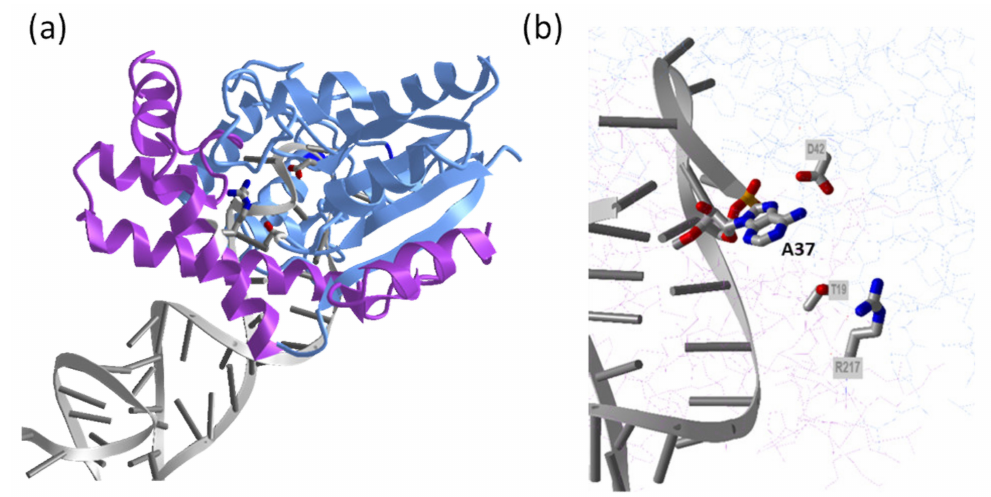
Figure 3. Structure of Escherichia coli tRNA IPT in complex with E. coli tRNA (Phe) . ( a ) Overall structure with the core domain shown in light blue, the insertion domain in magenta, and tRNA (Phe) in grey. ( b ) Close-up of the active site showing adenosine substrate (A37) on tRNA anticodon loop and conserved residues Asp, Thr, and Arg (D42, T19, and R217, respectively) involved in the catalysis. The images were drawn by iCn3D structure viewer [50] using PDB coordinates 3FOZ